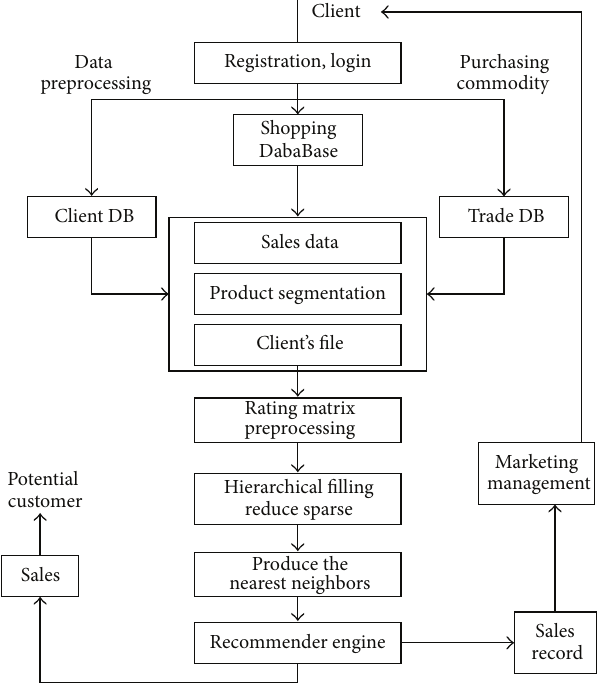
Figure 2: NewRec recommendation model.